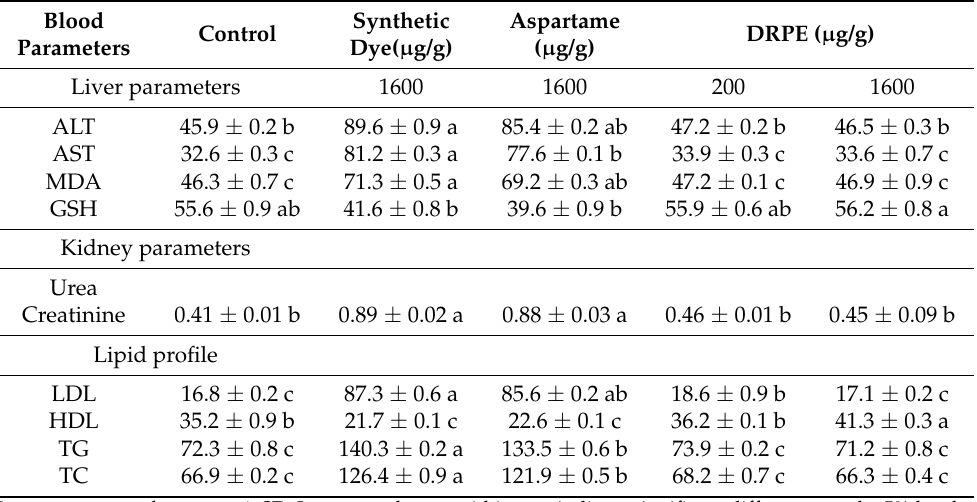
Table 3. Serum parameters of rats affected by synthetic dye, aspartame, and DRPE ( µ g/g). Synthetic Aspartame Blood DRPE ( µ g/g) Control Dye( µ g/g) ( µ g/g) Parameters Liver parameters 1600 1600 200 1600 ALT 45.9 ± 0.2 b 89.6 ± 0.9 a